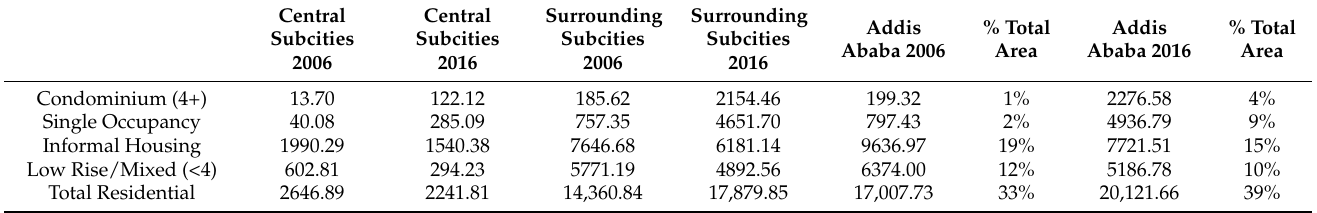
Table 5. Residential housing comparison between the center and the